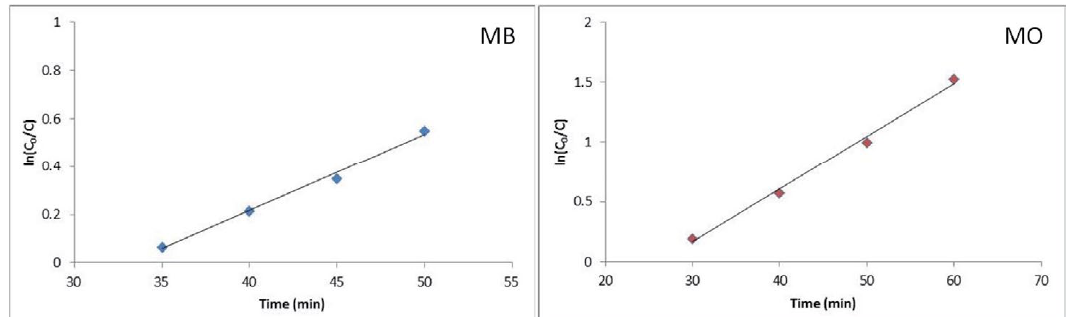
Fig. 8. Kinetics of photocatalytic degradation of MB and MO dyes using TiO